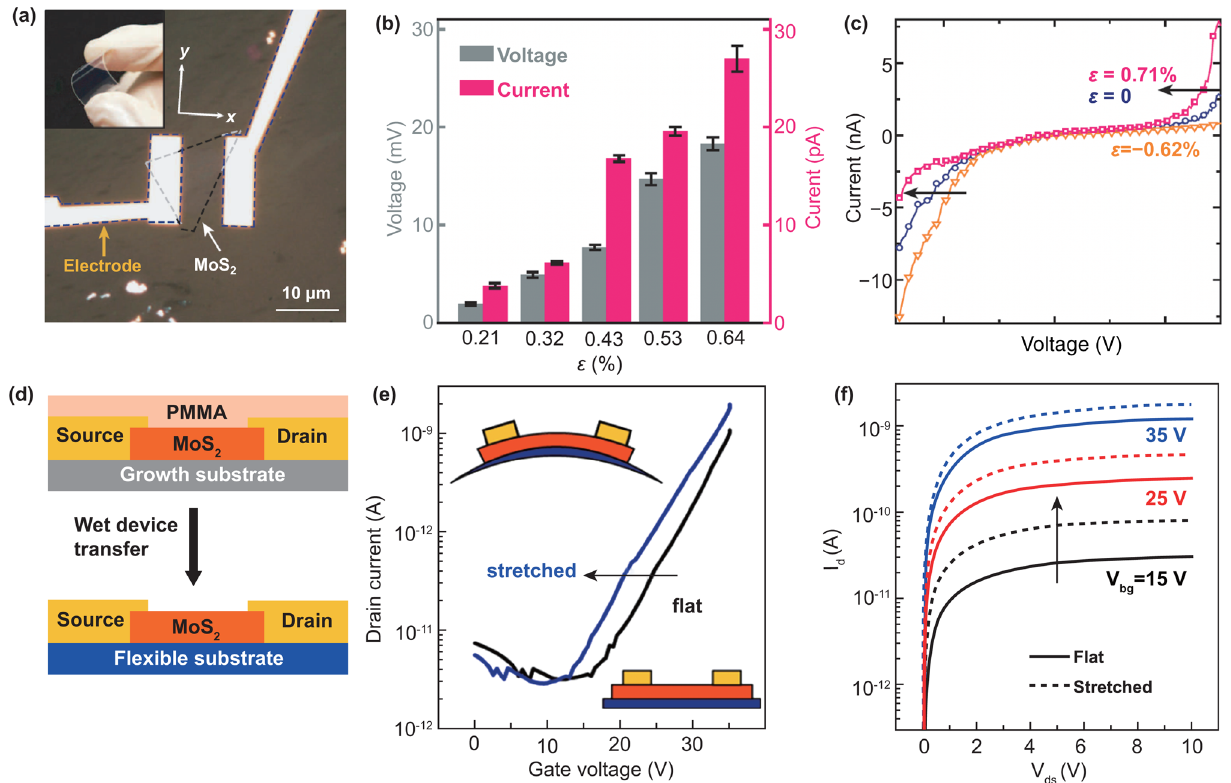
Fig. 6 Applying strain on 2D semiconductors by flexible devices. a A flexible device with monolayer MoS 2 flake along armchair direction. b Evolution of the piezoelectric outputs with increasing number of atomic layers in MoS 2 flakes. c Asymmetric modulation of I – V curve by strains shows the piezoelectric effect. Reproduced with permission [39]. Copyright 2014, Nature Publishing Group. d Schematic diagram of flexible device and fabrication process. e Transfer curves and f I – V curves of a flexible monolayer MoS 2 transistor measured before applying strain and applying 0.07% strain. Reproduced with permission [127]. Copyright 2015, American Chemical